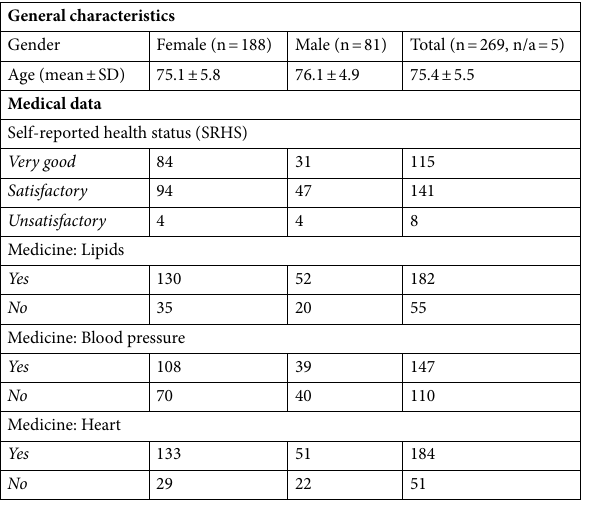
Table 1. Background data among participants in the methylation study (n = 274). *n number of samples. n/a no